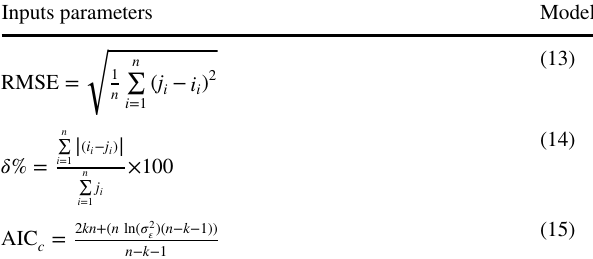
Table 7 Indicators for evaluation the proposed hybrid approach Inputs